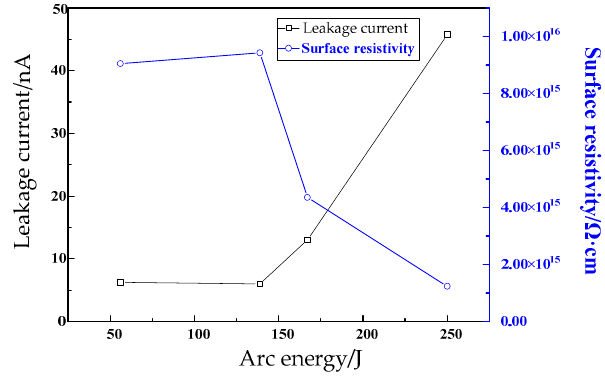
Figure 12. The leakage current and surface resistivity under different arc energy.